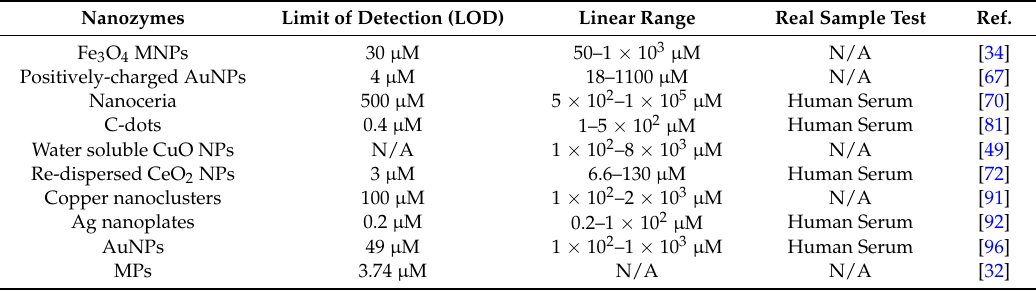
Table 1. Analytical performance comparison of the single component nanozyme methods for the detection of glucose.